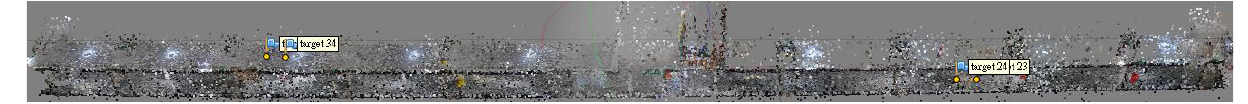
Figure 9. The most suitable scale bars placement in this experiment.